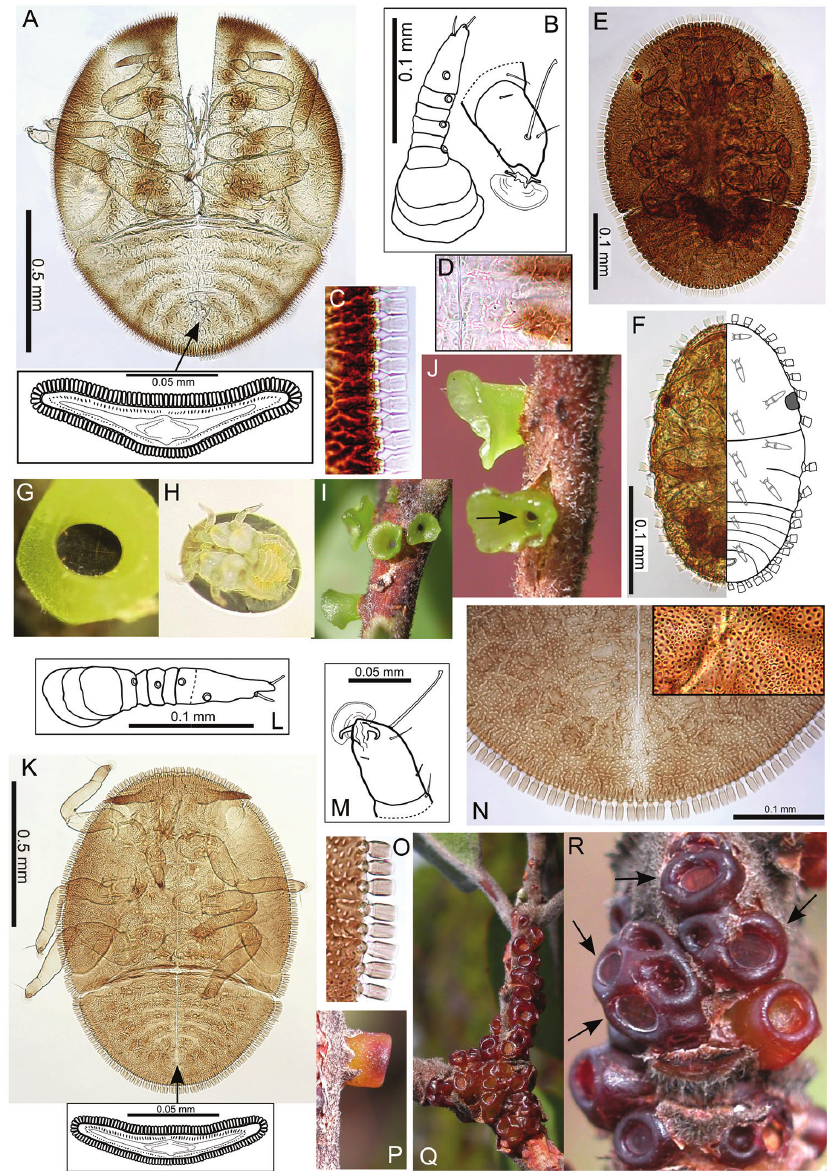
Figure 49. Pariaconus caulicalix and Pariaconus crassiorcalix immatures. A–J P. caulicalix : A 5 th instar with anal ring detail (inset) B antenna and tarsi C detail of marginal sectasetae D ridged dorsal surface E 2 nd instar F 1 st instar (with acute sectasetae on dorsum) G, H (images by Russell Messing): G immature seated at base of cup gall H soft ventral body beneath dark sclerotized dorsal surface I, J cup gall tissue extrudes from the plant stem with dark immatures seated in the base (indicated) K-R P. crassiorcalix : K 5 th instar with anal ring detail (inset) L antenna M tarsi N abdomen with detail of dorsal surface with round tubercle like scales O detail of marginal sectasetae P, Q, R cup gall tissue extrudes from the plant stem with orange-brown immatures seated in the base